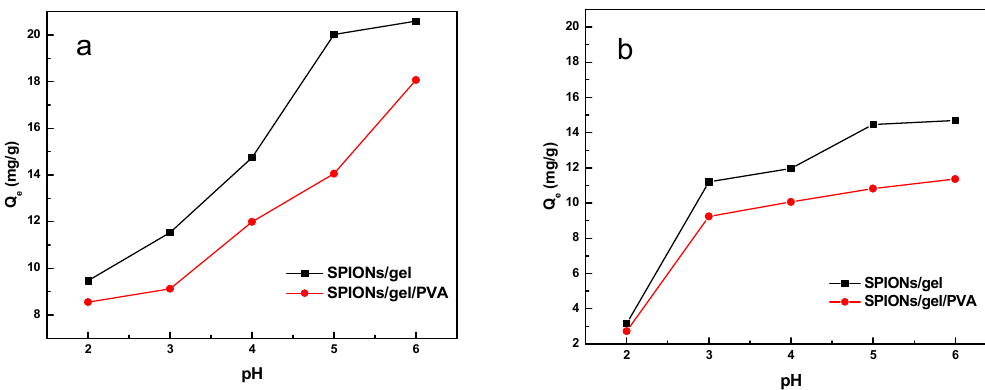
Figure 6. Effect of pH on Cu(II) ( a ) and Zn(II) ( b ) ions adsorption by SPIONs/gel and SPIONs/gel/PVA.